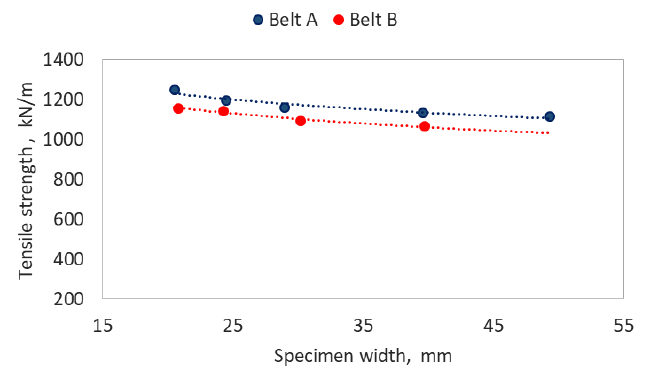
Figure 1. Influence of belt width on the results of belt strength tests.